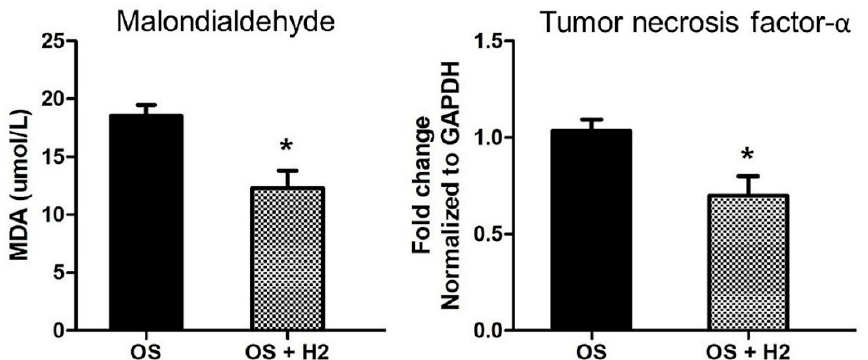
Figure 3. Effect of molecular hydrogen on irradiation-induced lipid peroxidation and inflammation. The marker of oxidative stress, malondialdehyde (MDA), was elevated in blood plasma after irradiation of rat myocardium. Application of molecular hydrogen (H 2 ) significantly decreased the levels of MDA. Myocardium irradiation increased levels of the inflammatory marker TNF- α in the rat´s heart tissue. Significant reduction of TNF- α was observed after H 2 treatment. OS = oxidative stress, H 2 = molecular hydrogen. Values are means ± SD, n = 5, *: p < 0.05. Modified from reference [8].